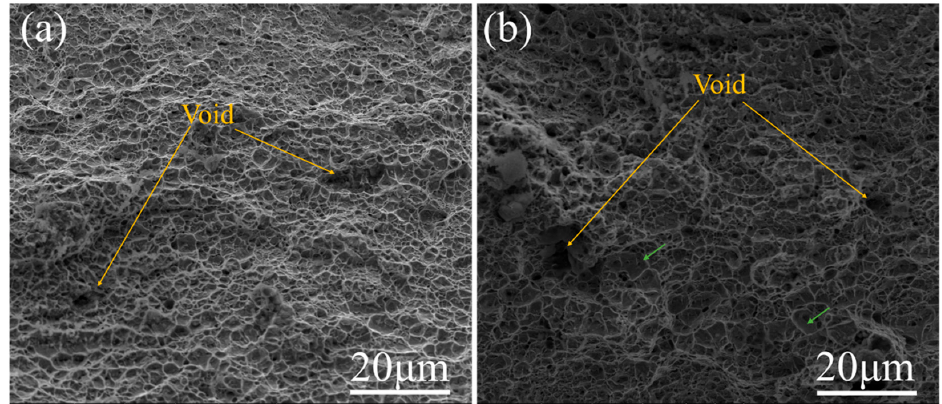
Figure 7. SEM image of the fracture: ( a ) MS81, and ( b )